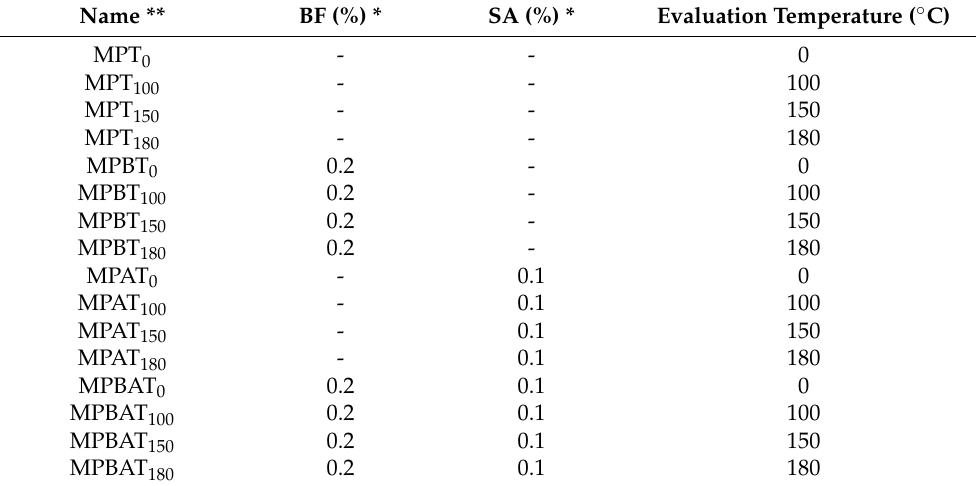
Table 6. Details of PC in the main